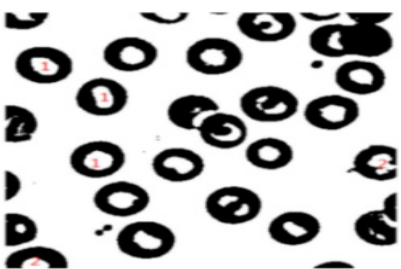
Figure 6. Holes in a binary image.